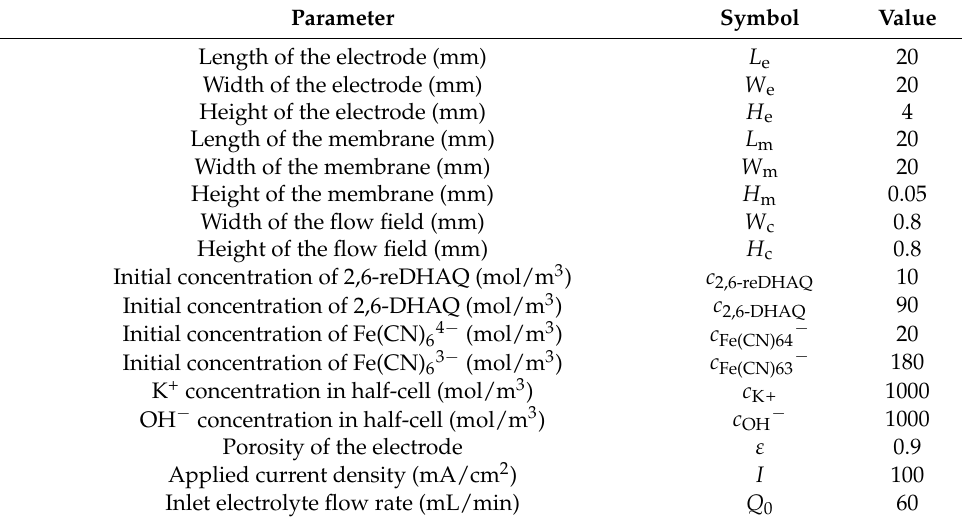
Table 2. Geometric and operation parameters used in the